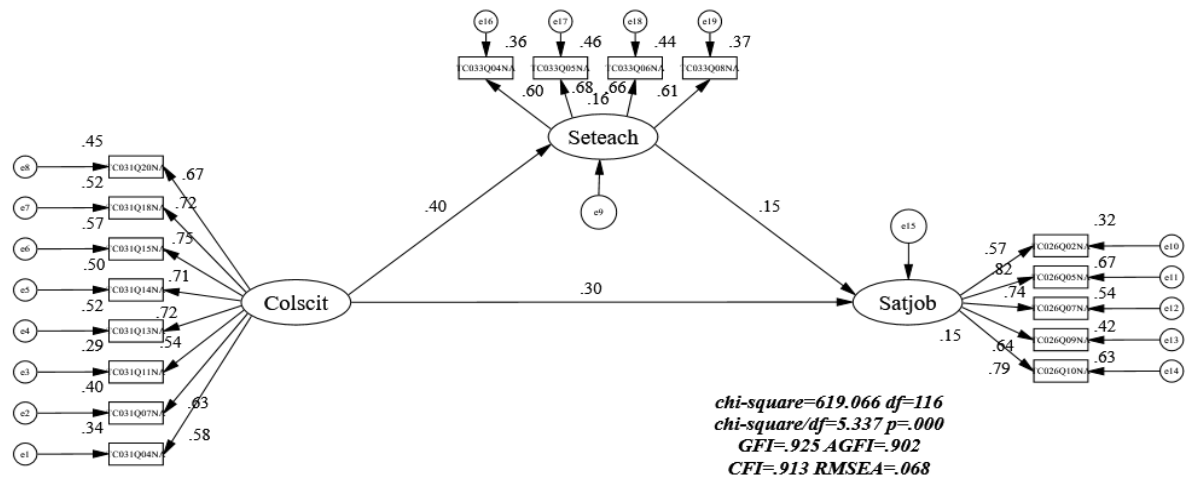
Figure 2. The Result of Mediation Model for the Science Teacher.